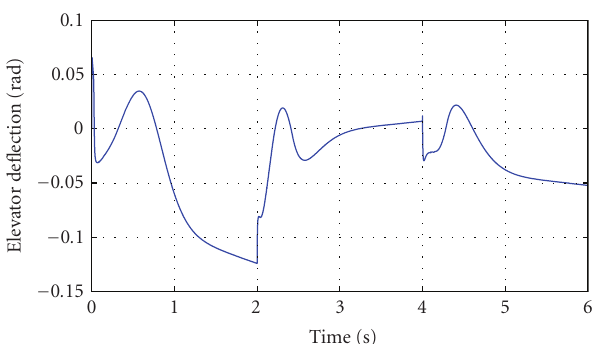
Figure 11: Input control with